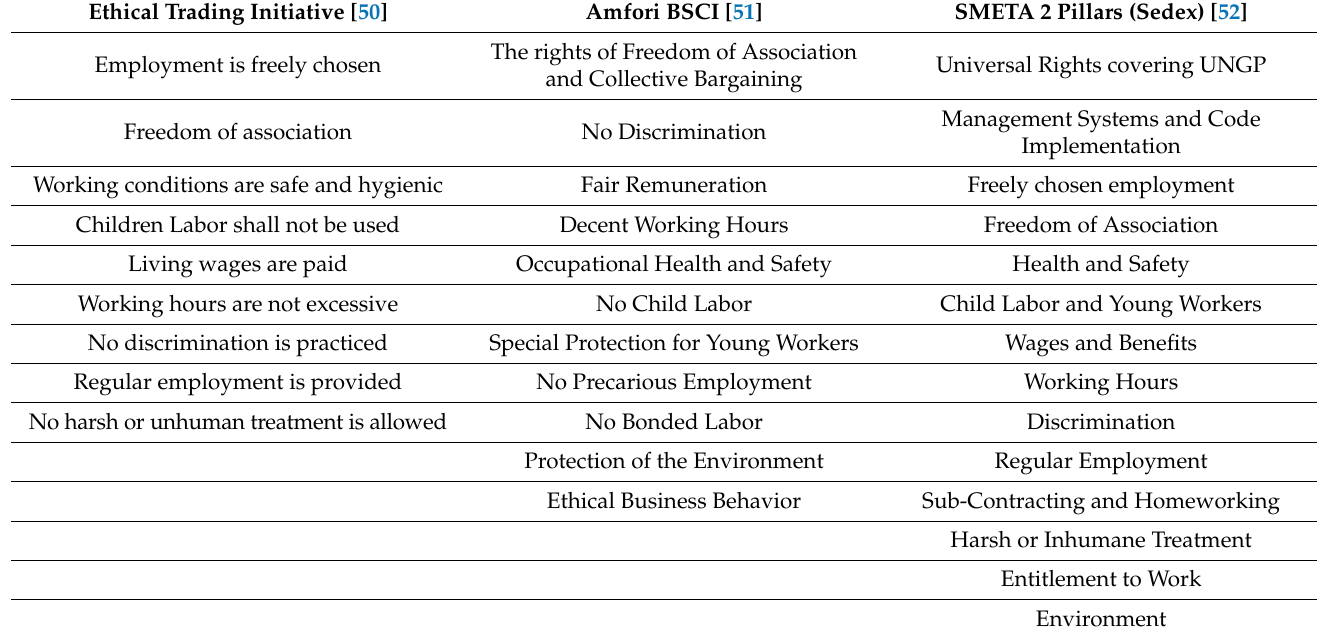
Table 3. Social responsibility